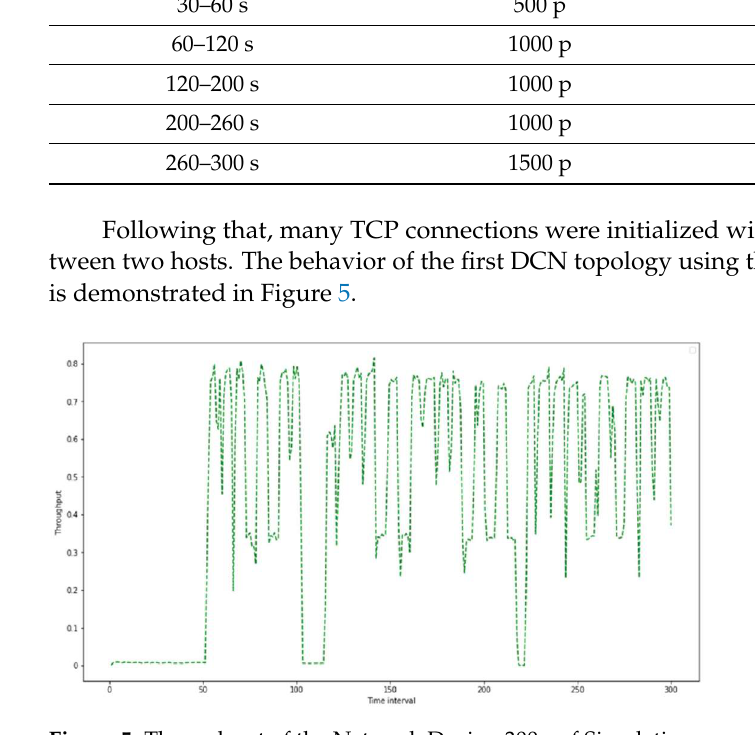
Figure 6. Steps of Preprocessing. 4.1.3. Flow Characterization and Cluster Analysis The first aim of this project is to develop a flow characterizing mechanism based on the metrics of network performance. Unsupervised machine learning techniques were proposed to achieve this goal. K-means as unsupervised clustering can create clusters of flow without the need for predefining the classes. This algorithm isutilized to understand